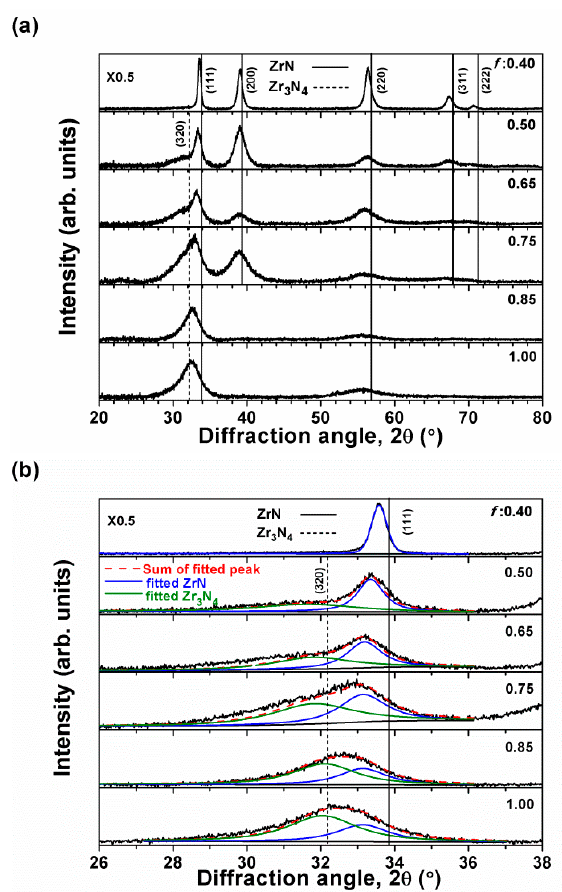
Figure 2. ( a ) and ( b ) X-ray diffraction (XRD) patterns of ZrN x films prepared using various N 2 flow ratios ( f ).